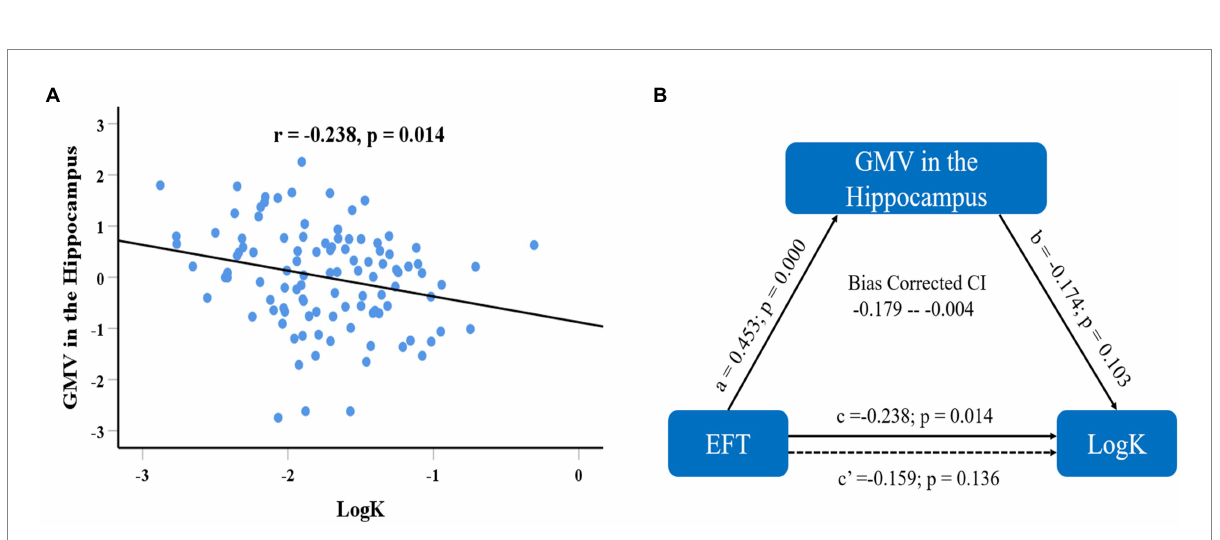
FIGURE 4 Scatter plot shows the correlations of delay discounting with regional GMV in the hippocampus (A) after adjusting age, sex, fluid intelligence, and total GMV. Mediation analysis showed that GMV of the hippocampus mediated the effect of EFT ability on delay discounting (B) , and the indirect effect accounts for 33.2% of the total effect [( c – c ′ )/ c